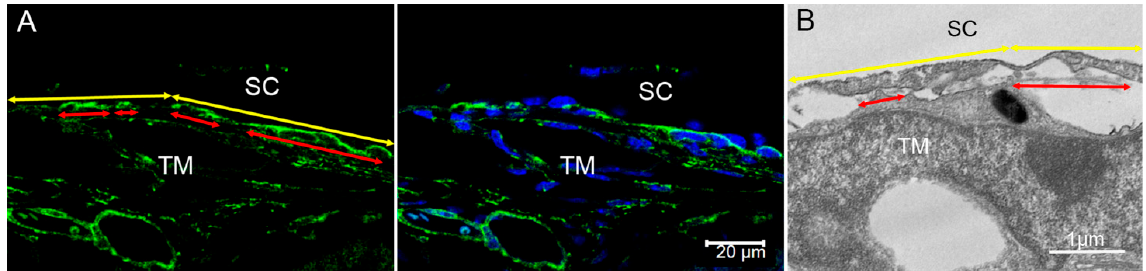
Figure 12. Measurement Methods of PBML of the IW of SC. ( A ) Measurement methods of Percentage Basement Membrane Length (PBML) with confocal images. The left panel shows immunohistochemical staining of type IV collagen (green) to label the BM in the trabecular meshwork (TM). The right panel shows the same image merged with DAPI staining of nuclei (blue). The yellow double arrows represent the full length of the inner wall (IW) of Schlemm’s canal (SC), while the red double arrows represent the length of BM. PBML = Σ length of BM/ Σ IW length × 100%. ( B ) Measurement methods of PBML with electron microscopic images. The yellow double arrows represent the full length of the IW of SC, while the red double arrows represent the length of BM. PBML = Σ length of continuous BM/ Σ IW length ×